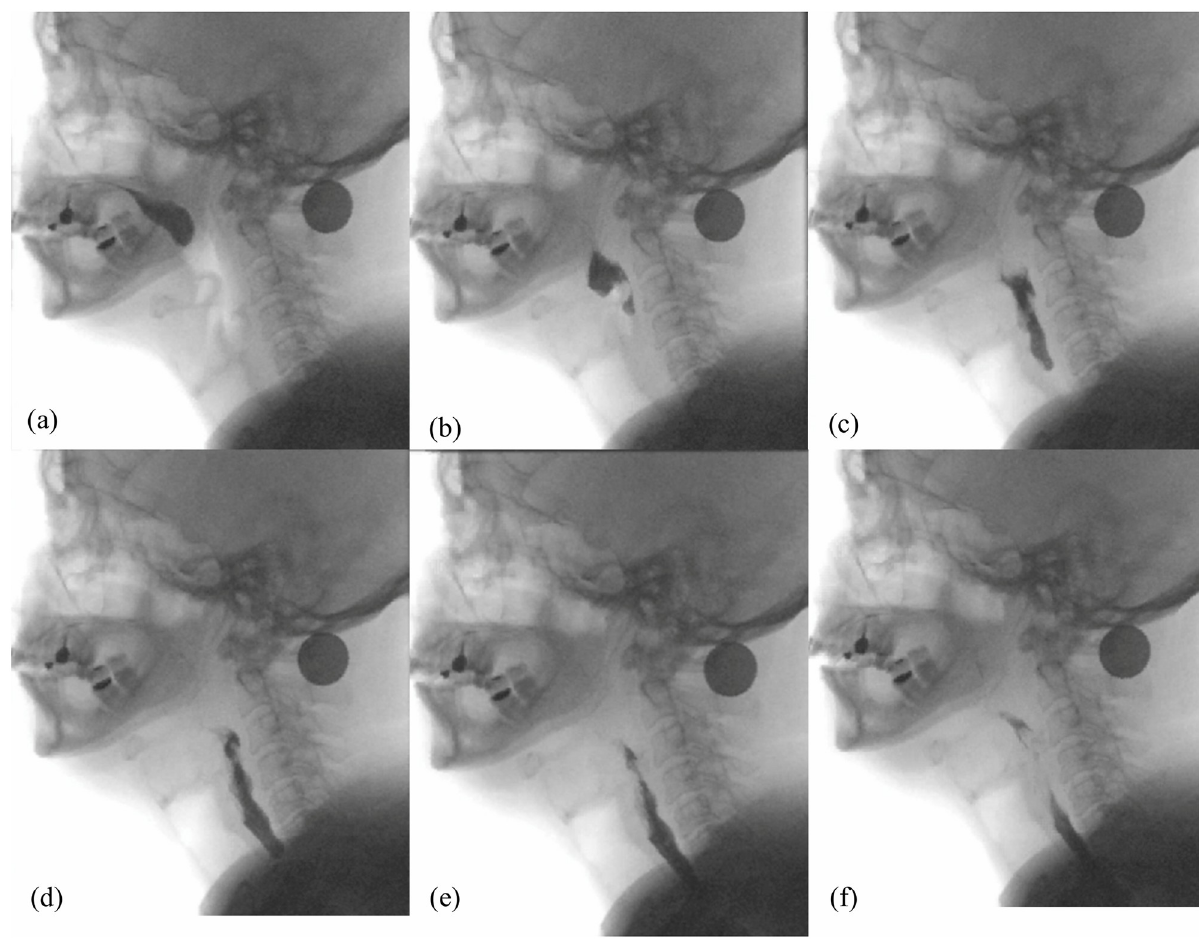
Fig 7. Successive VFS images of a normal pharyngeal phase of swallowing recorded from an around 50 years old subject (3 ml thick bolus of custard type texture). (a) [0 ms] Bolus pushed by tongue, entering the pharyngeal cavity. (b) [133 ms] Bolus at oropharyngeal level above epiglottis; larynx elevated. (c) [200 ms] Bolus squeezed by pharyngeal contraction; epiglottis tilted. (d) [267 ms] Bolus entering the open UES and the esophagus. (e) [400 ms] Continuation of pharyngeal contraction. (f) [533 ms] Bolus conveyed downwards by esophageal peristalsis; larynx descended. Note: the black disk is a 0.5 € coin serving as a fiducial